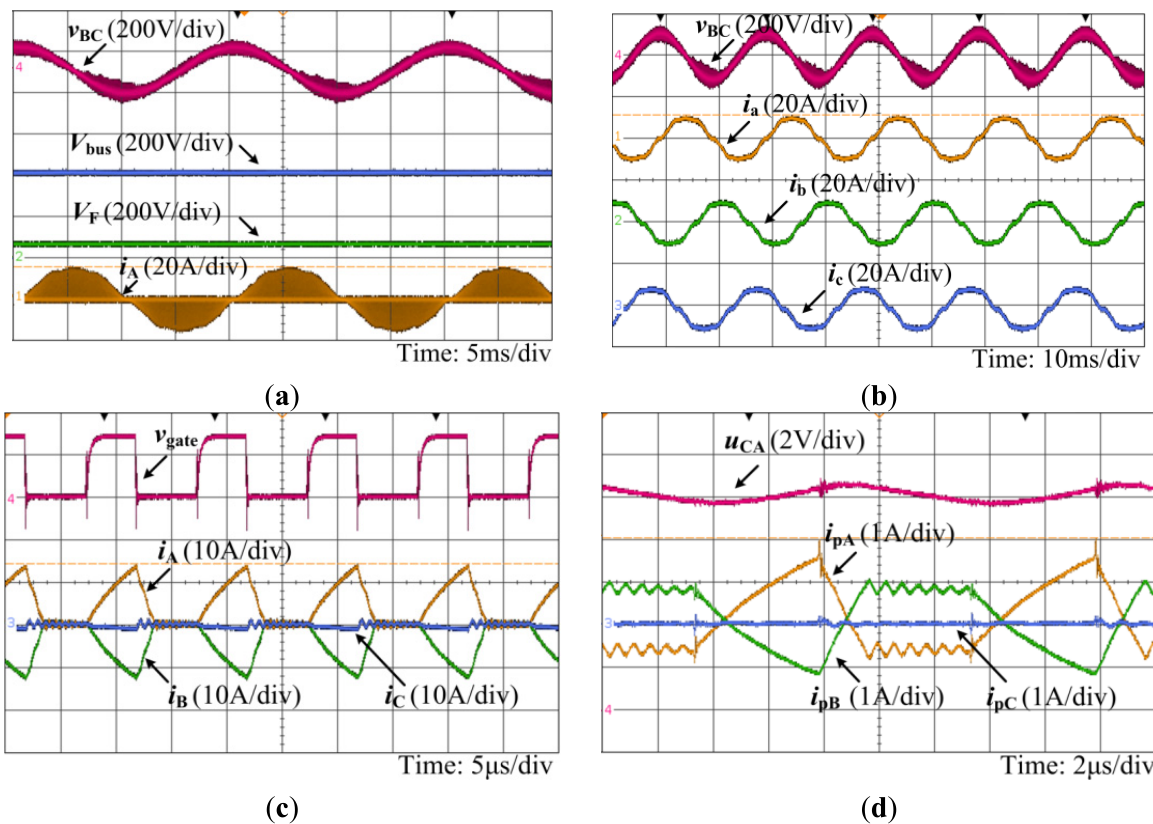
Figure 19. Experimental results under the rated conditions. ( a ) input line voltage, output voltage and input current; ( b ) input line voltage and PMSM output currents; ( c ) gate signal and three phase input current in detail; ( d ) u CA and secondary currents of flyback